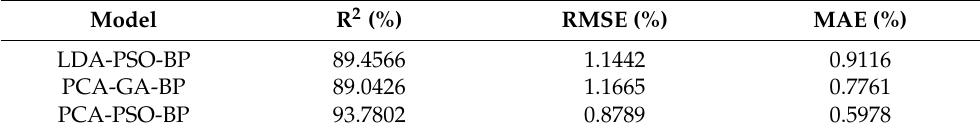
Table 4. Prediction results of the different models when the moisture content was greater than 64%.